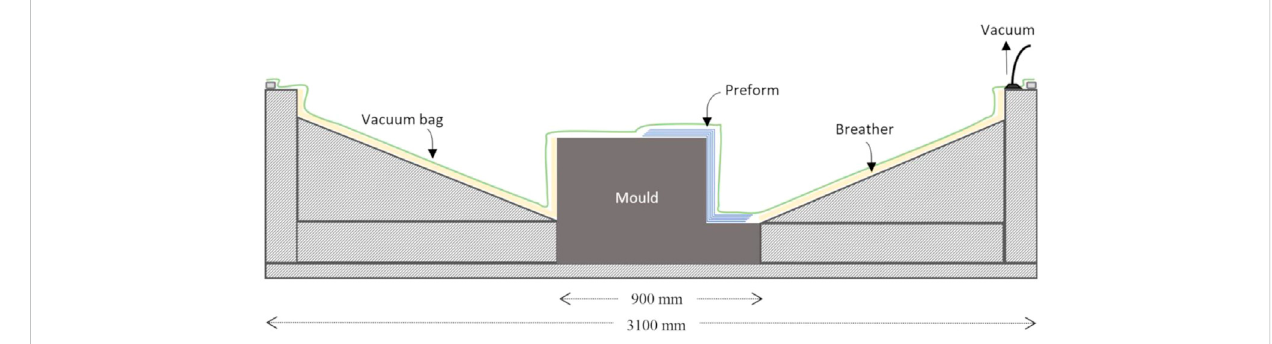
FIGURE 2 Tooling and geometry set up to ensure constant diaphragm kinematics.